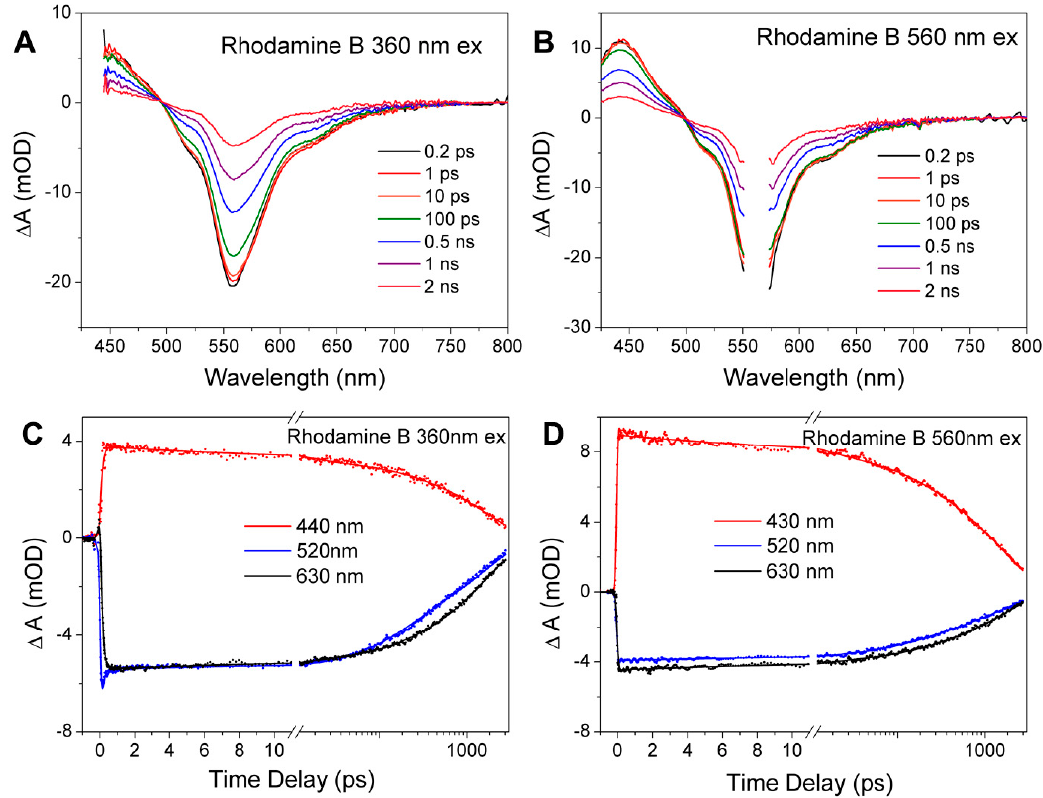
Figure 3. ( A , B ) Transient absorption spectra of Rhodamine B (dissolved in water) at di ff erent time Figure 3. ( A – B ) Transient absorption spectra of Rhodamine B (dissolved in water) at different time delays with excitation of 360 nm and 560 nm, respectively. ( C , D ) Transient absorption decays at delays with excitation of 360 nm and 560 nm, respectively. ( C – D ) Transient absorption decays at di ff erent probe different probe wavelengths.